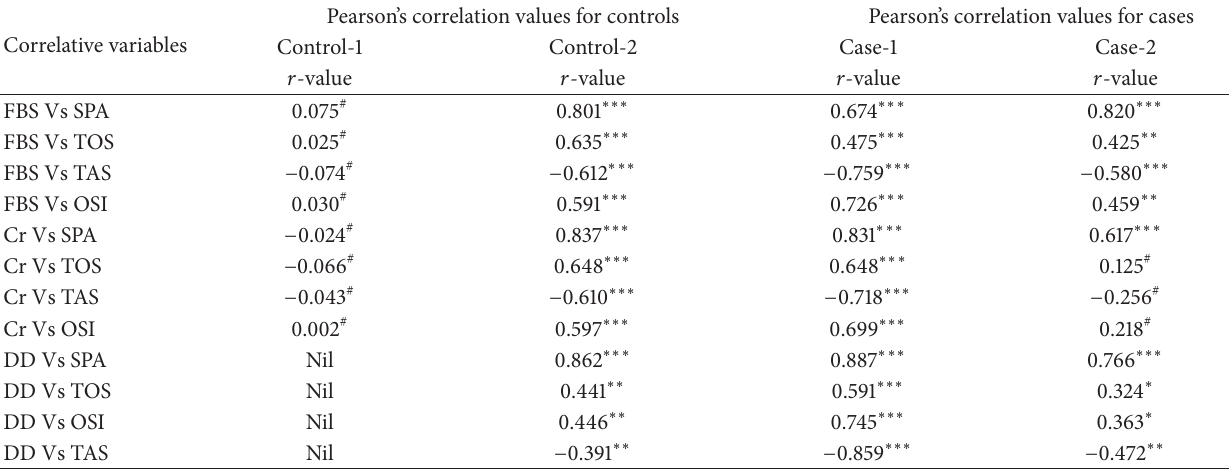
Table 4: Representation of Pearson’s correlation values for different comparison groups. FBS was nonsignificantly correlated to SPA, TOS, TAS, and OSI in control-1, while significantly correlated in control-2, case-1, and case-2. Nonsignificant correlation was observed between creatinine and SPA, TOS, TAS, and OSI in control-1, while significant in control-2 and case-1.